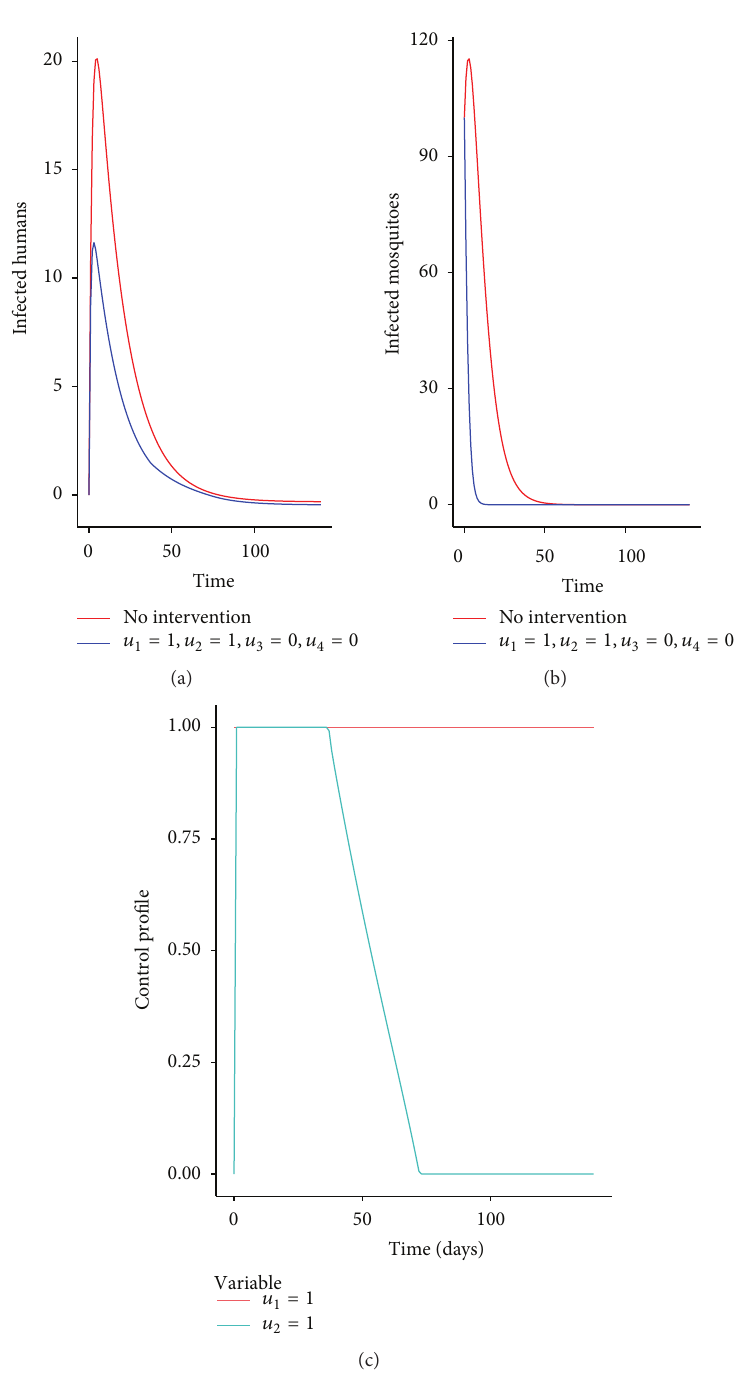
Figure 4: Simulations of the model showing the effect of ITNs and treatment on the spread of malaria for the endemic setting.